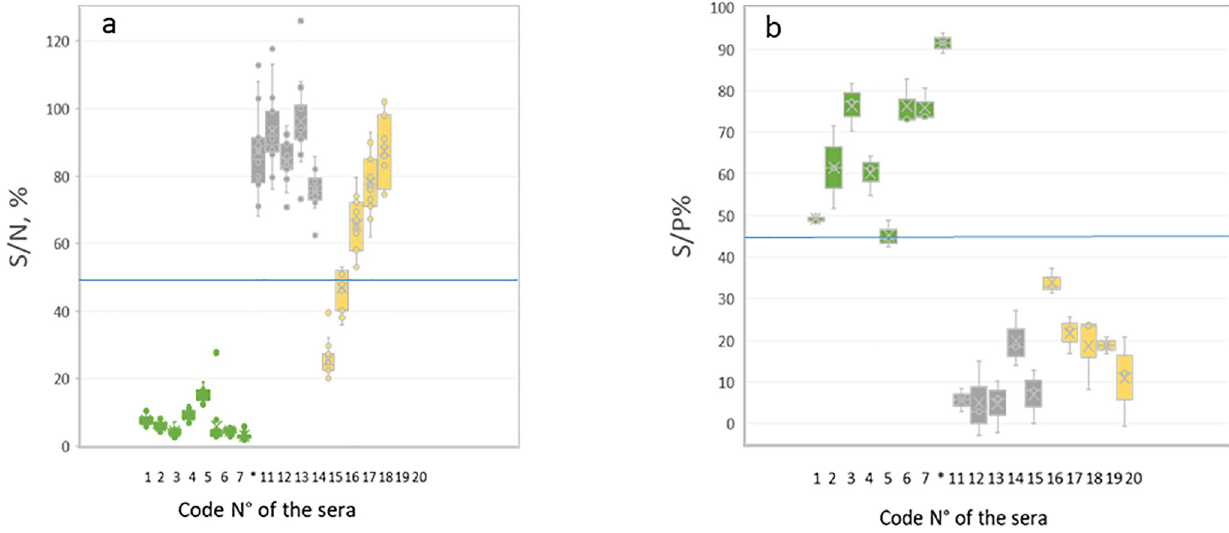
Fig 2. Serological distribution of the RVF PT panel sera according to the two commercial kits (a) ID Screen 1 Rift Valley Fever Competition Multi- species and (b) INgezim FVR Compac. The star � or. indicate the sera N˚8 to 10, corresponding to the repeatability criteria.